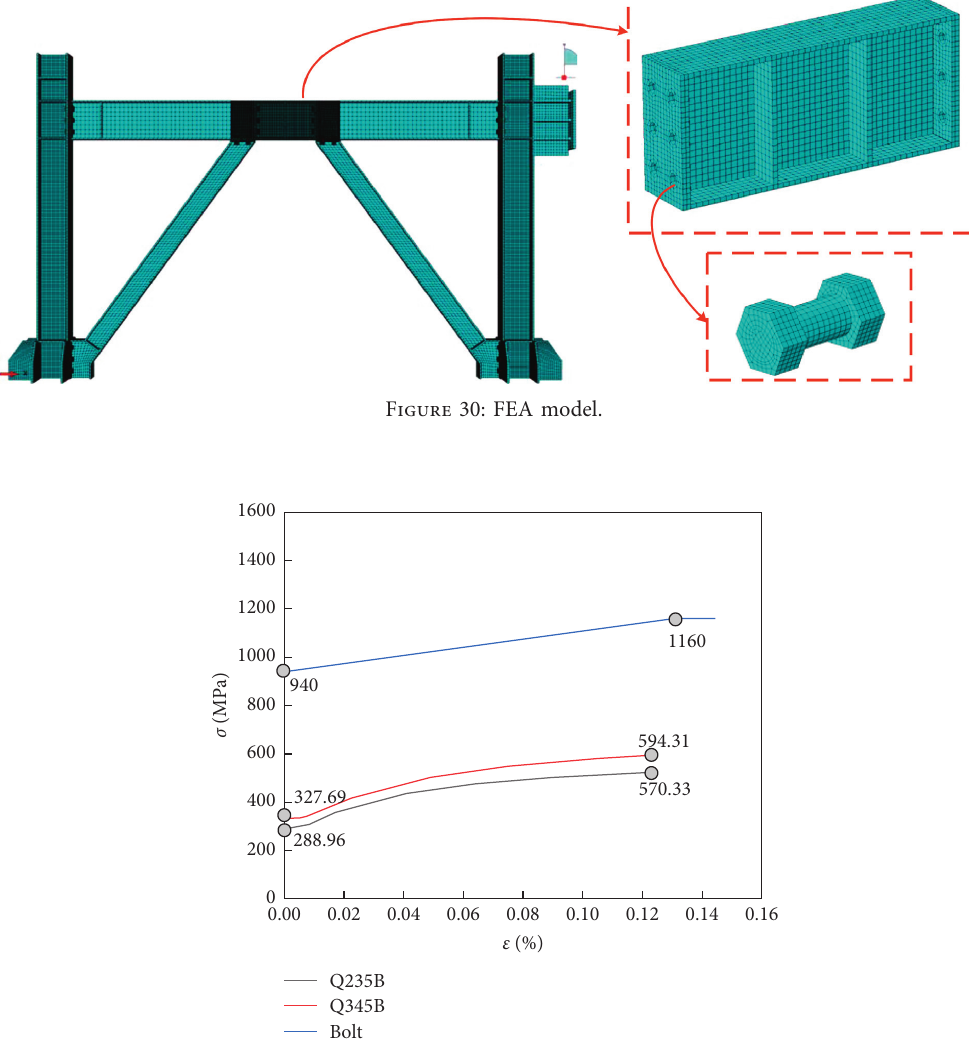
Figure 31: Stress-strain curves for different